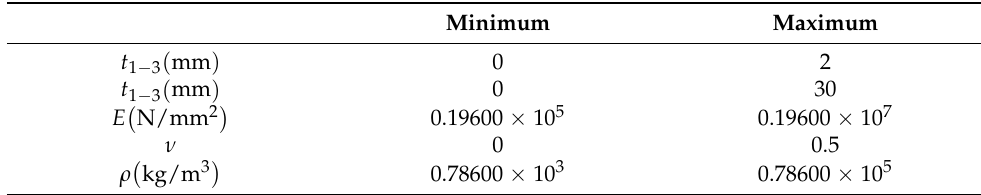
Table 6. Optimization